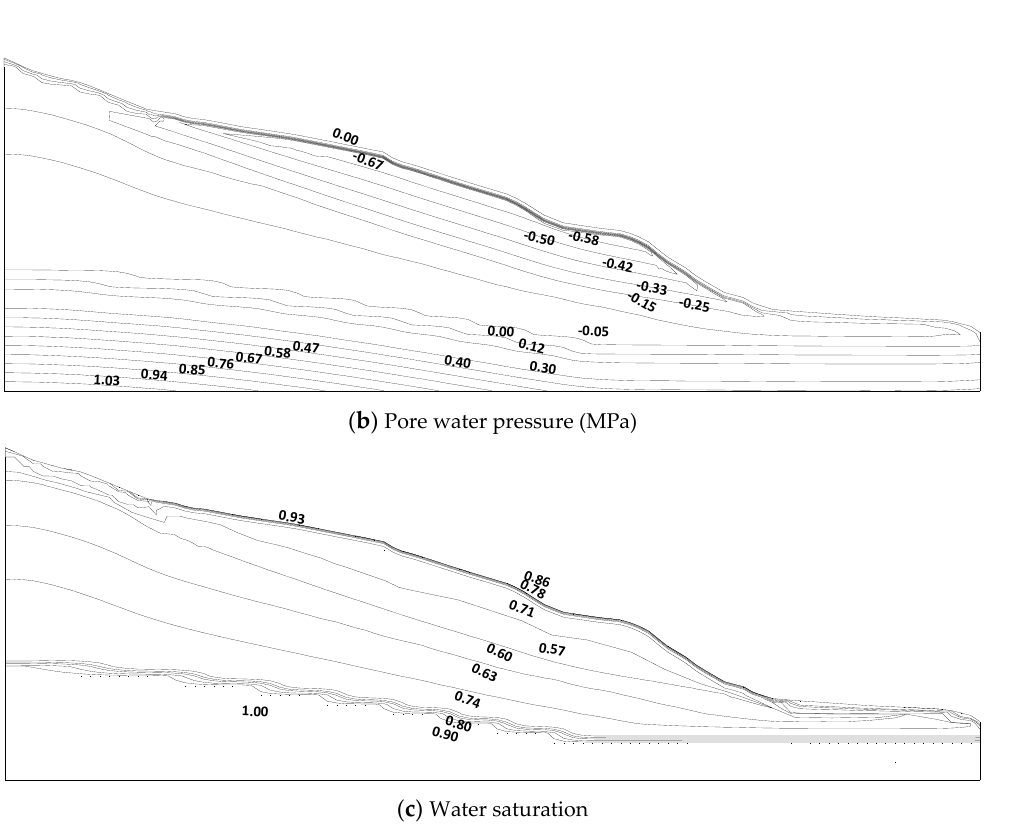
Figure 10. Contour distribution pictures of three parameters at the rainfall time of 2 h.